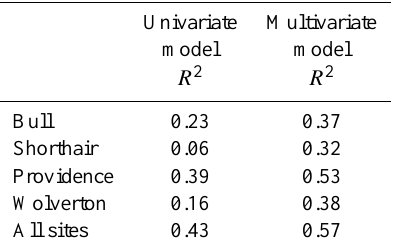
Table 4. Coefficients of determination of univariate and multivariate linear-regression